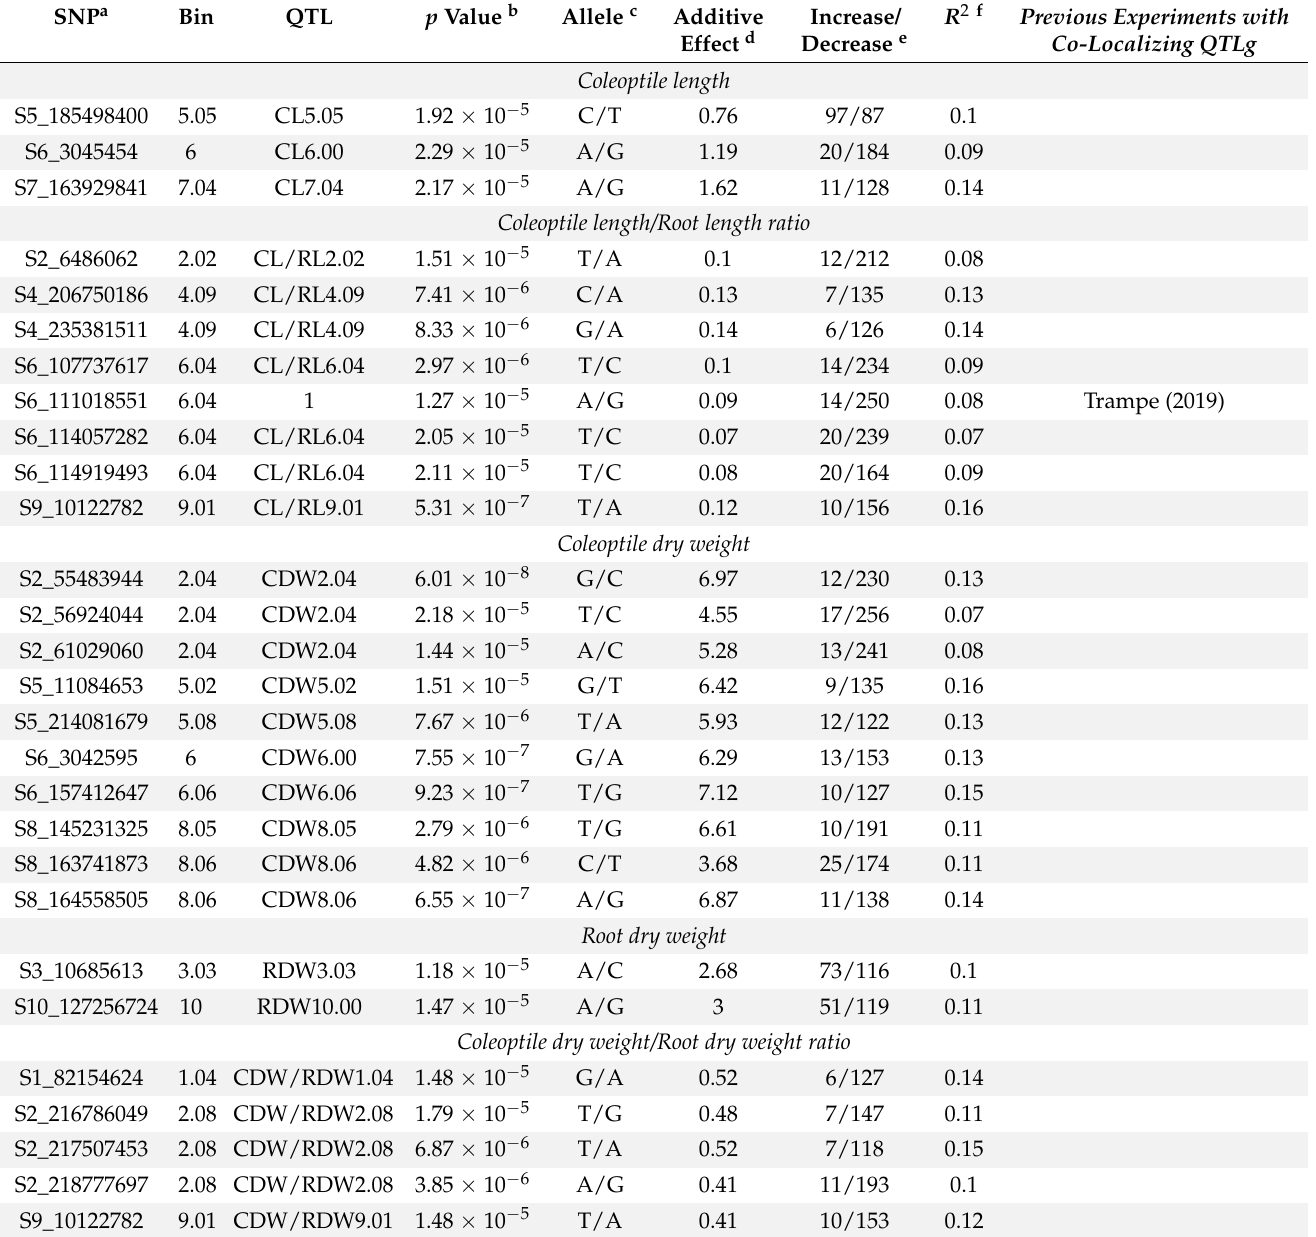
Table 3. SNPs significantly associated with germination and seedling establishment related traits under water stress obtained with 200 g L − 1 of Polyethylene glycol 6000. Chromosome position (bin), the number of QTLs, the significance of the association, the number of RILs with favorable and unfavorable alleles, the additive value, and the variance explained by each SNP are included in the